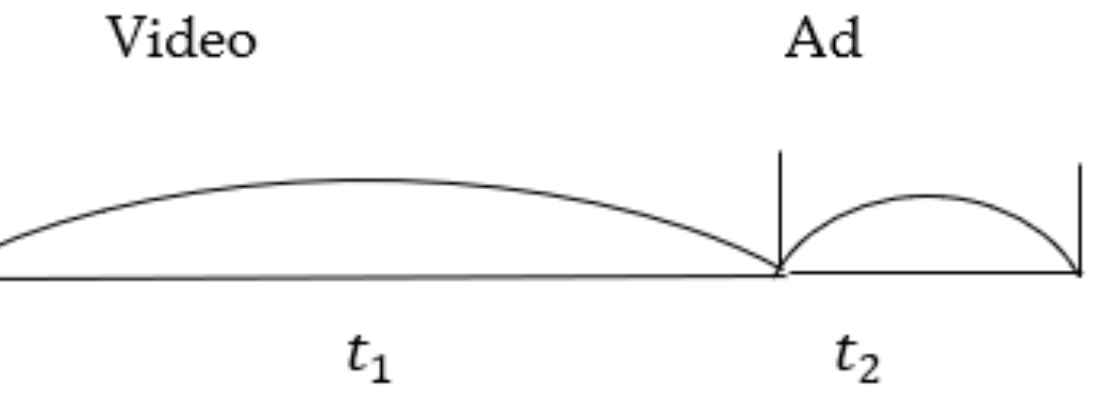
Figure 1. Distribution of programs and advertisements on video platforms.